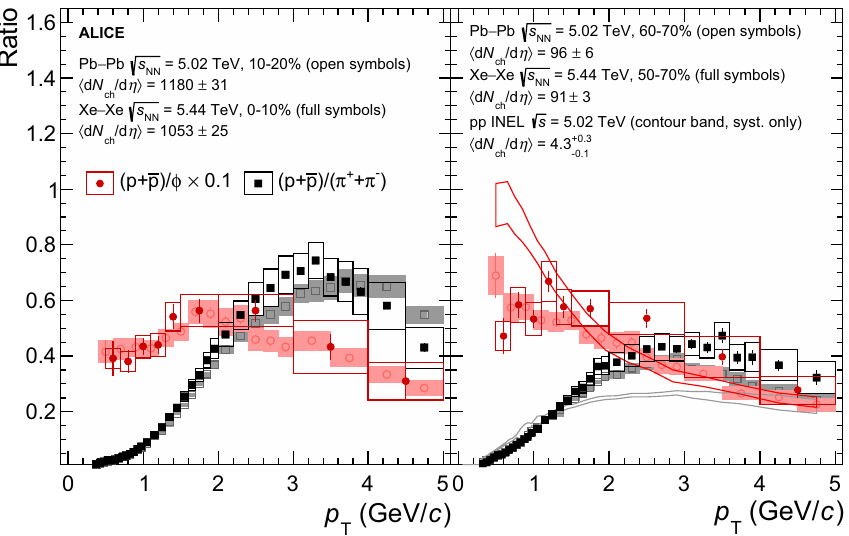
Fig. 4 Left: proton-to-phi and proton-to-pion p T -differential ratios in ity bins have similar (cid:6) d N ch / d η (cid:7) (see text for details). The statistical √ s NN = 5 . 44 TeV and 10 − 20% 0 − 10% central Xe–Xe collisions at and systematic uncertainties are shown as error bars and boxes around √ s NN = 5 . 02 TeV [26]. Right: proton- the data points. The p T -differential ratios measured in pp collisions at √ central Pb–Pb collisions at s = 5 . 02 TeV [11,26] are also shown in the right panel for compar- to-phi and proton-to-pion p T -differential ratios in 50 − 70% Xe–Xe √ s NN = 5 . 44 TeV and 60 − 70% Pb–Pb collisions at √ collisions at ison. The bands represent the systematic uncertainties s NN = 5 . 02 TeV [11,26]. The two selected groups of central-